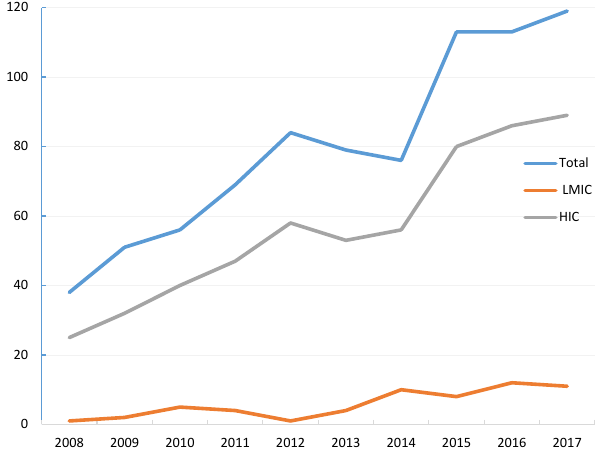
Figure 2. Number of Single-Author Articles Per Year by Country Income Group.